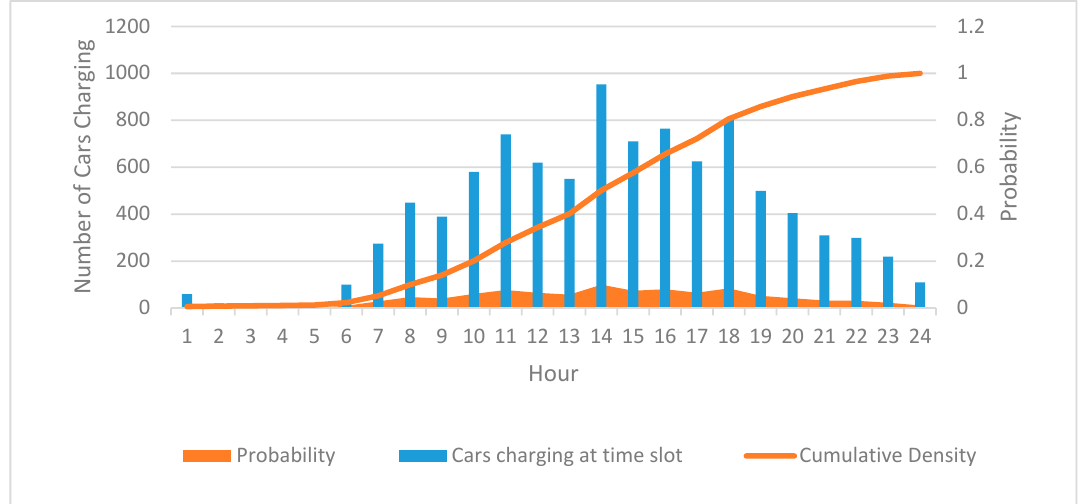
Figure 6. EV State of Charge Estimation [13].